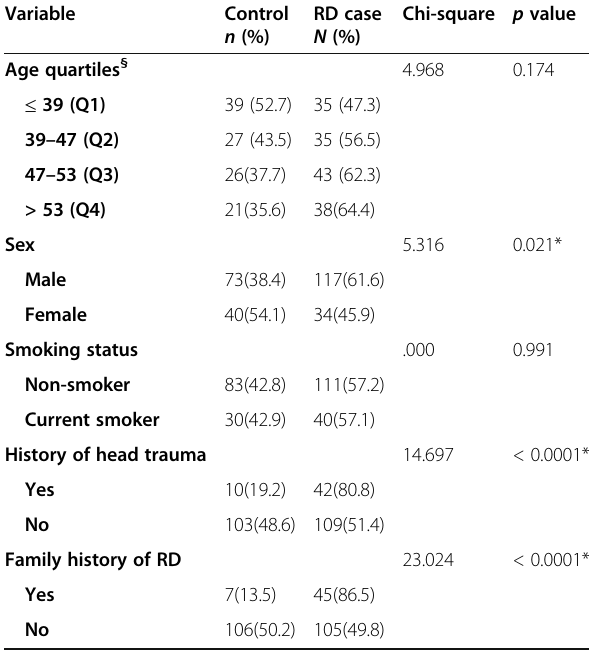
Table 1 Comparison between cases of retinal detachment and controls regarding socio-demographic characteristics and family history of retinal detachment, Ain Shams Outpatient Ophthalmology clinic, Cairo, Egypt,